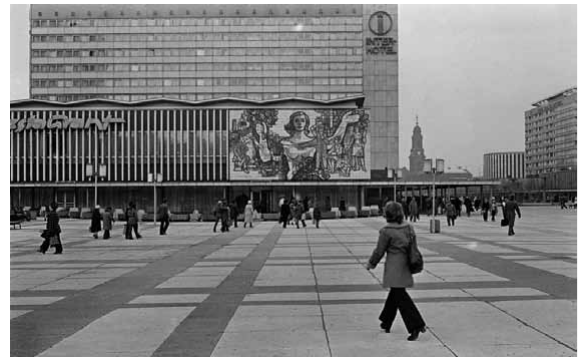
fig. 5. Dresden grüßt seine Gäste (1968/69) . restaurant Bastei, Prager Straße, 1981. SluB Dresden / Deutsche fotothek / Christian